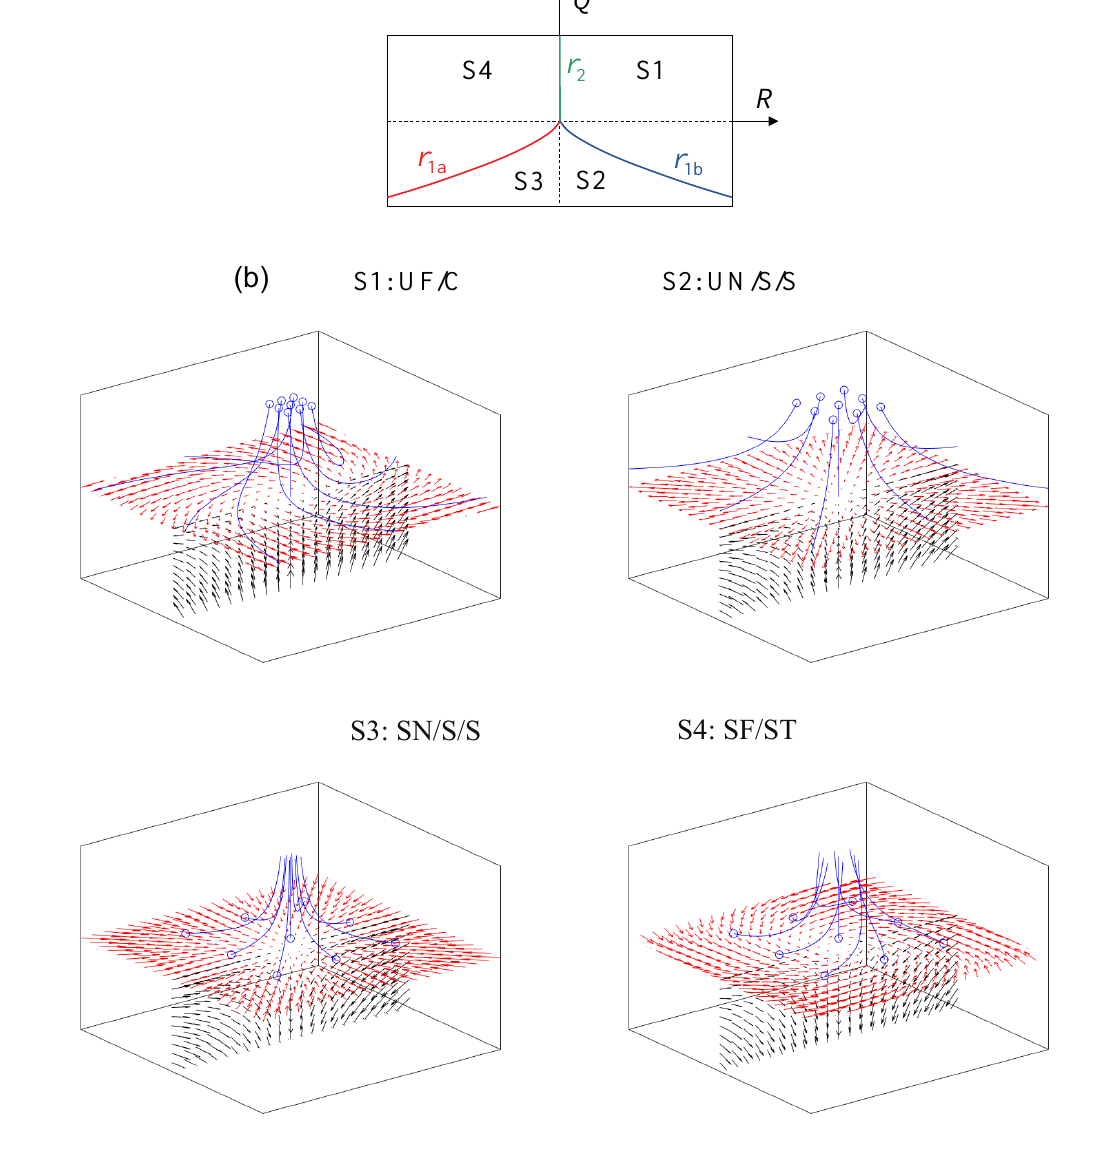
Figure 1. ( a ) Classification of topologies S1–S4 and projection of topology borders R 1 a , R 1 b and R 2 in the Q − R plane for P = 0. Dashed lines indicate Q = 0 and R = 0, respectively. ( b ) Graphical representation corresponding to UF = unstable focus; UN = unstable node; SN = stable node; SF = stable focus; C = compressing; S = saddle; ST = stretching. The blue circles indicate the origin of the blue